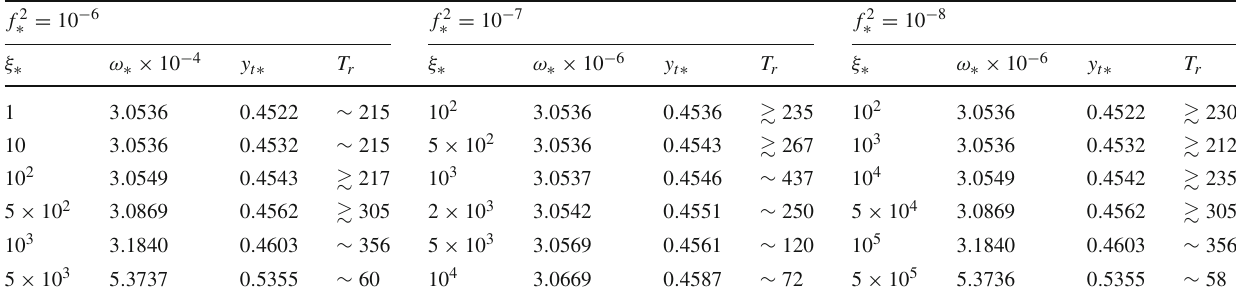
Table 1 Initial values for the various coupling parameters. These are for f 2 ∗ = 10 − 6 , 10 − 7 and 10 − 8 . We took λ ∗ = 0 . 1 and ρ ∗ = 1 . 5. Here for three different values of f 2 ∗ we took (cid:2) = 10 − 12 , 10 − 15 and 10 − 16 .